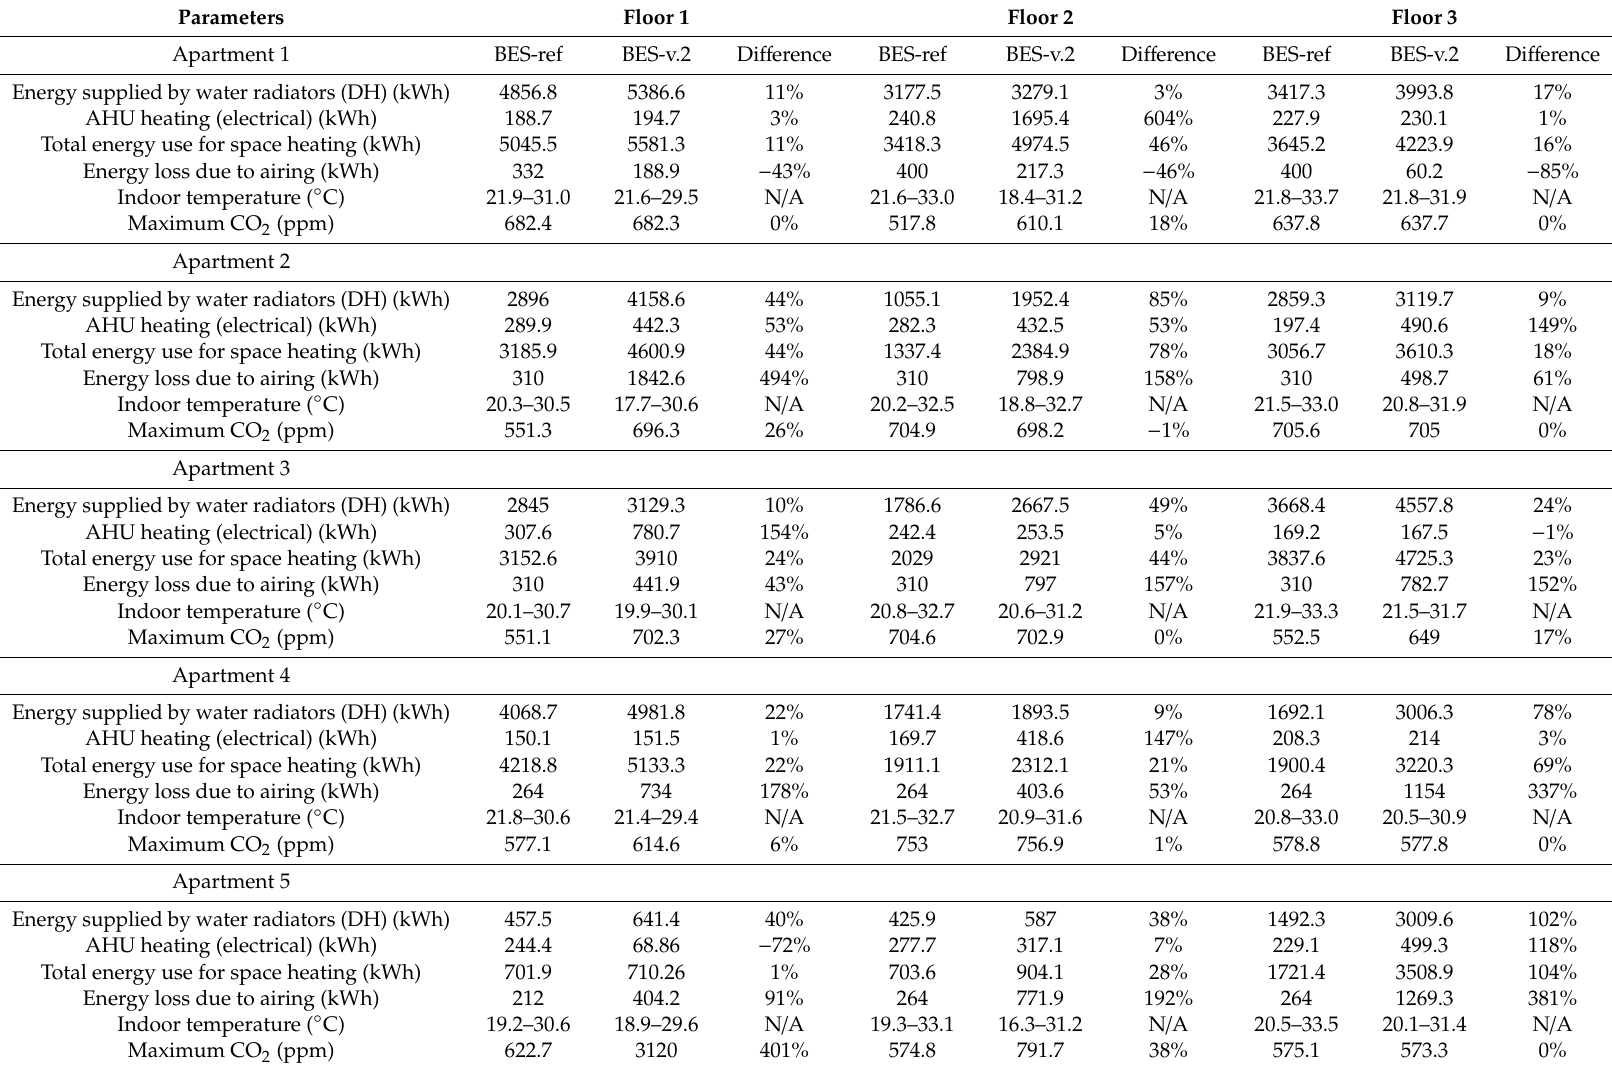
Table 12. Results from yearly simulations at the apartment level for both models (BES-ref and